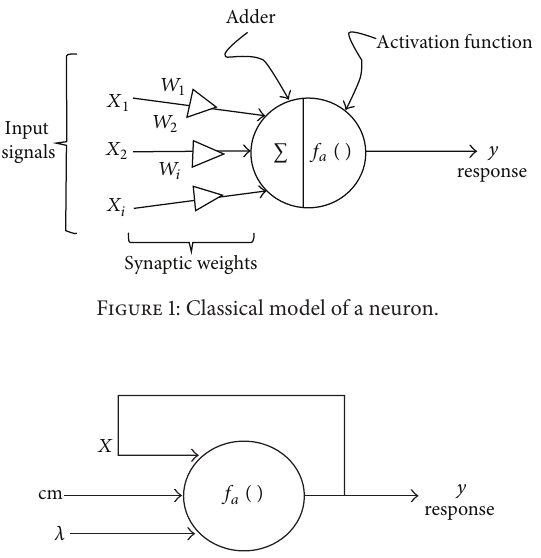
Figure 2: Single recurrent artificial Gaussian